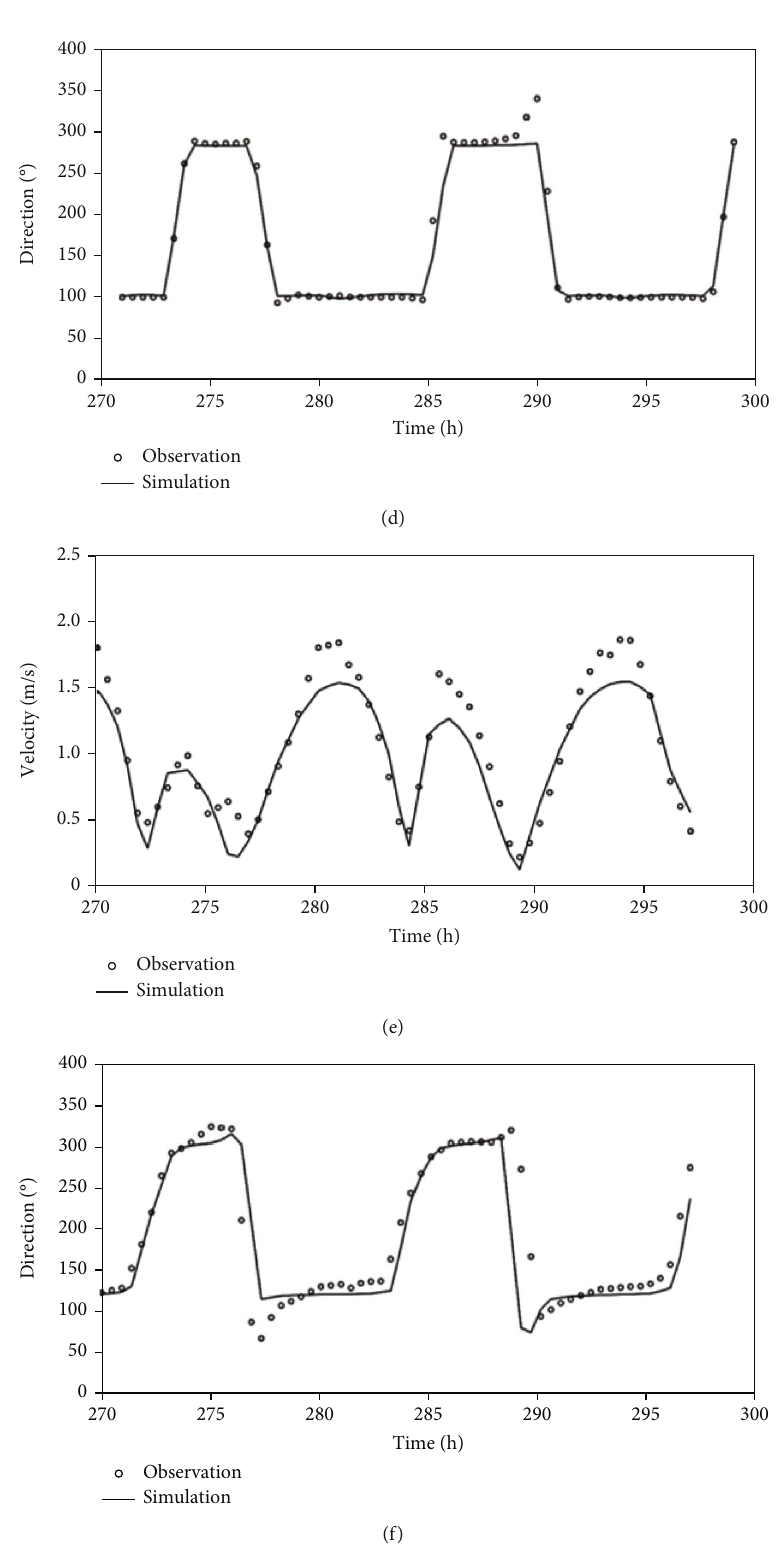
Figure 7: Veri fi cation of vertical average fl ow velocity and direction. (a, b) NGN4S. (c, d) CS9S. (e, f) NCH6